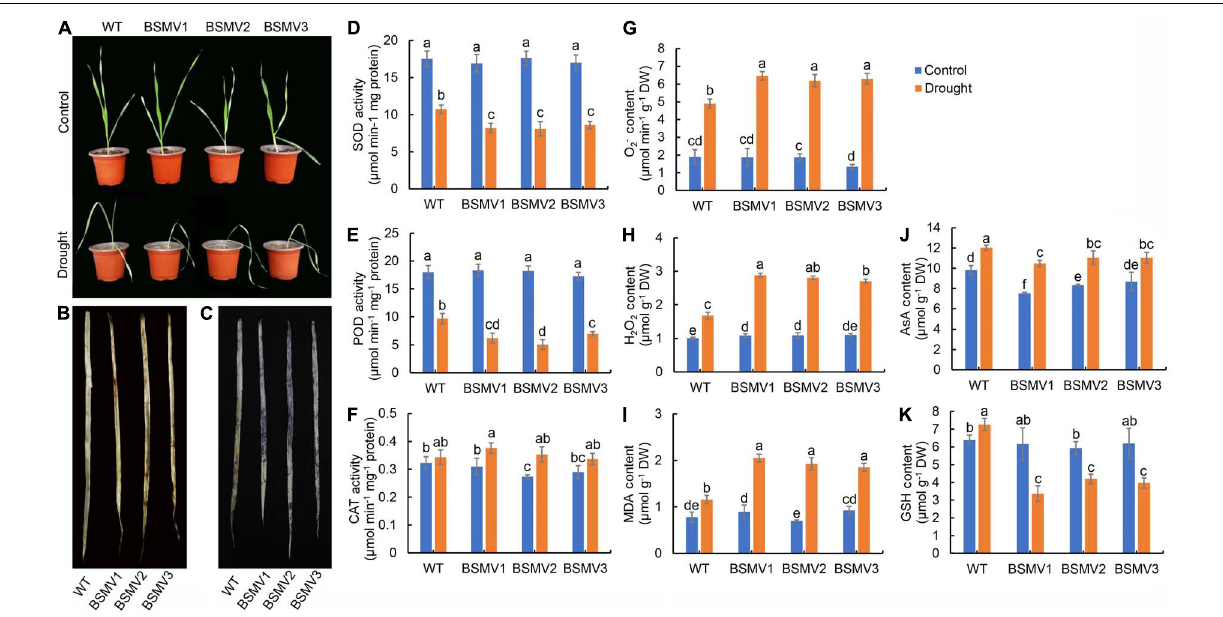
to Baudin and Tadmor, the cell membrane of EC_S1 was